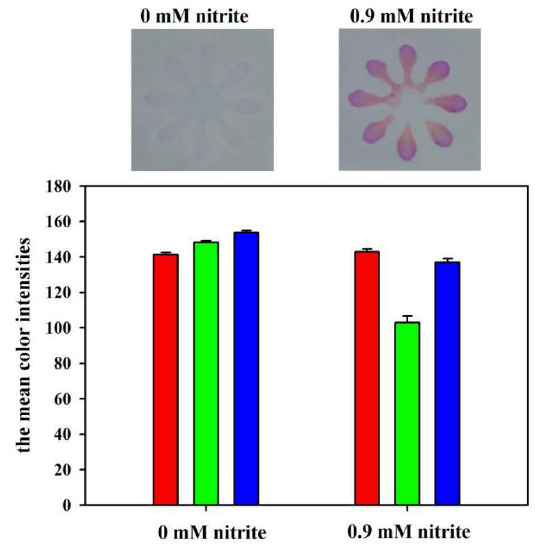
Figure 5. The color values for the developed μPADs after reacting with the blank and the nitrite standard (0.9 mM). The red, green, and blue vertical bars in the figure represent the mean colour intensities for the Red, Green, and Blue channels, respectively.